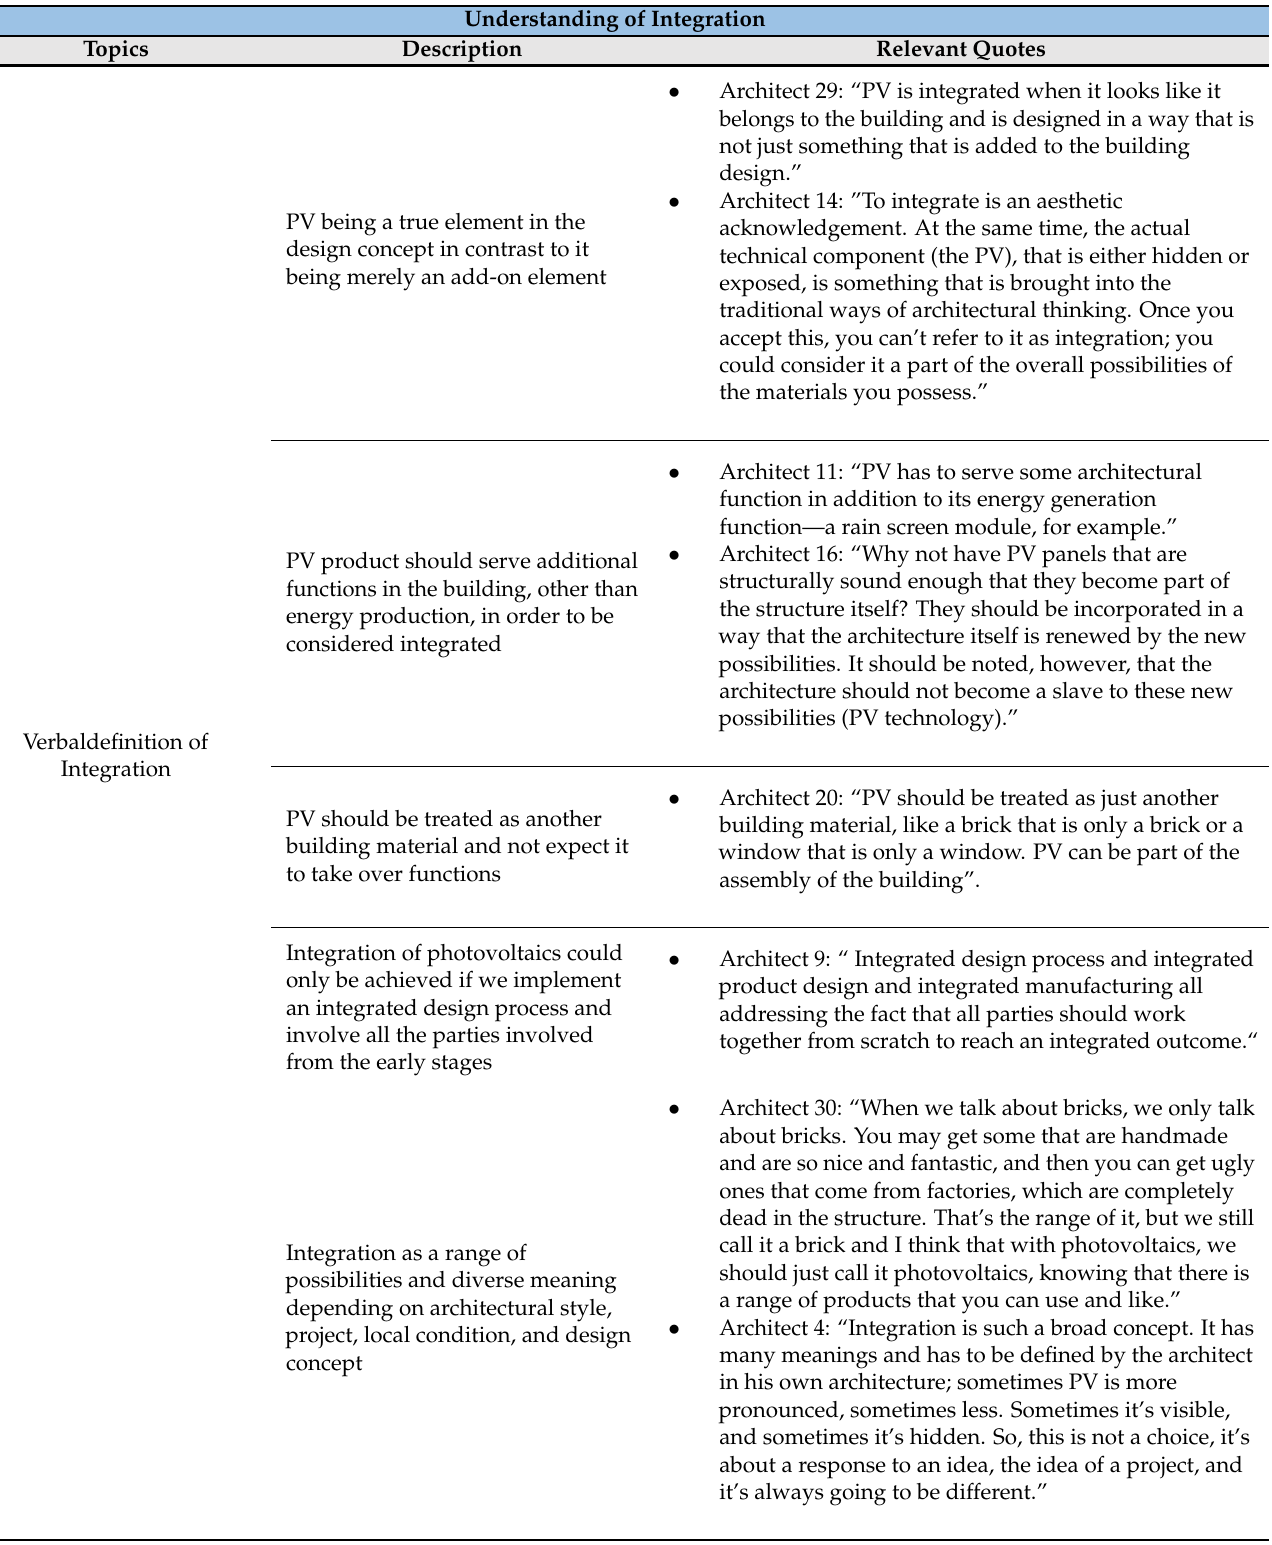
Table 3. Understanding of